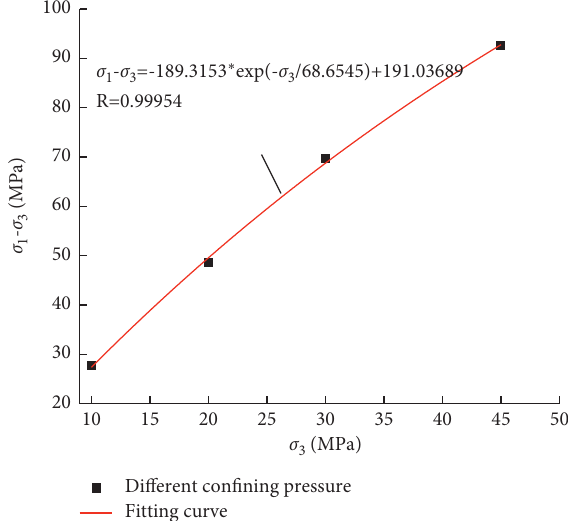
Figure 6: The relationship between deviatoric stress and confining pressures with the water content of